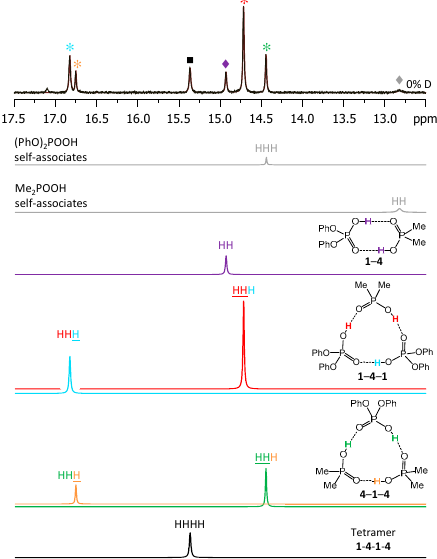
Figure 7. The low-field part of the 1 H NMR spectrum of the sample containing acids 1 and 4 (1.2:1) in CDF 3 /CDF 2 Cl at 100 K. The experimental spectrum is deconvoluted into the sub-spectra arising from self-associated of 1 or 4 , heterodimer 1 - 4 , two heterotrimers, 1 - 4 - 1 and 4 - 1 - 4, and a tetramer, consisting of two molecules of 1 and two molecules of 4 in an alternating fashion 1 - 4 - 1 - 4 . For visual clarification the signals in the experimental spectrum and the computed sub-spectra are color coded. Trimers, dimers, and tetramers are marked by asterisks, diamonds, and squares, respectively.